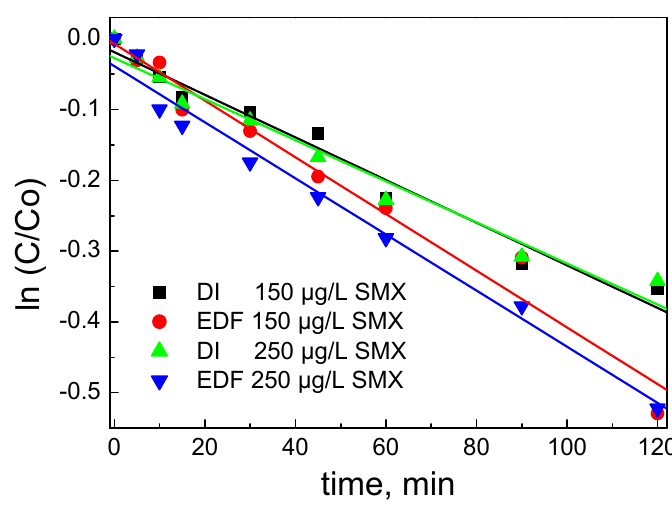
Figure 12. Linear dependence of the logarithm of SMX concentration ratio for the catalysts studied. The concentration of SMX is presented.